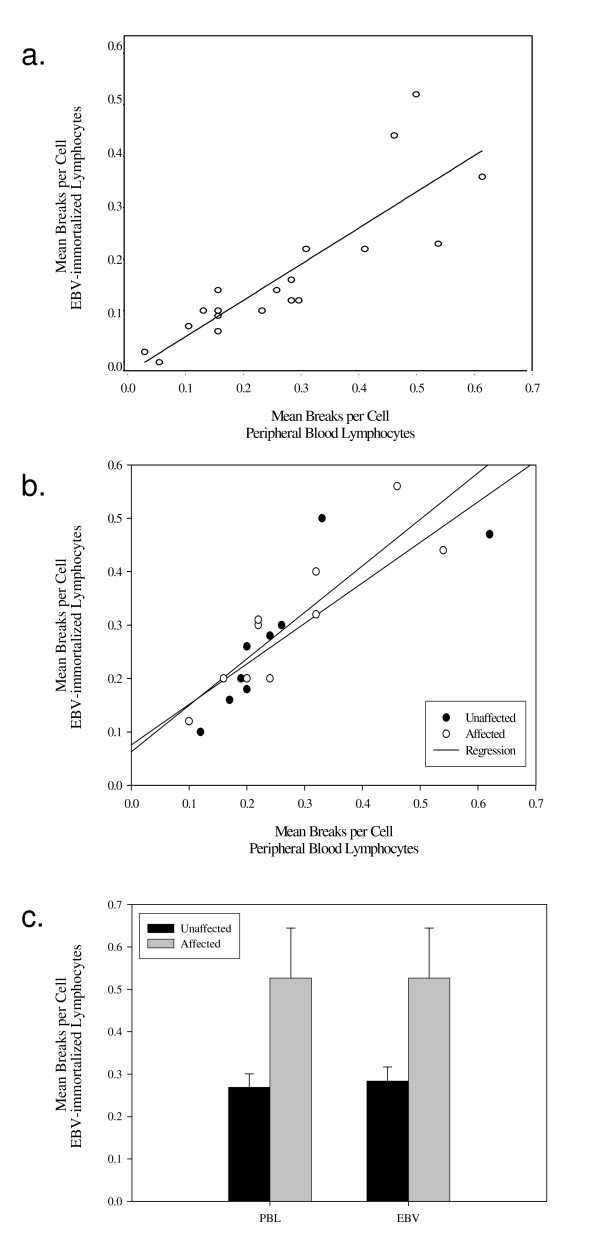
Correlation of MBPC in peripheral blood lymphocytes and EBV-immortalized cell lines. a) Scatter plot of paired peripheral blood lymphocytes and EBV-immortalized cell lines MBPC. b) Peripheral blood lymphocytes and EBV-immortalized cell line MBPC stratified by cancer status. c) Bar graph representing stratification by cancer status and type of cell line.